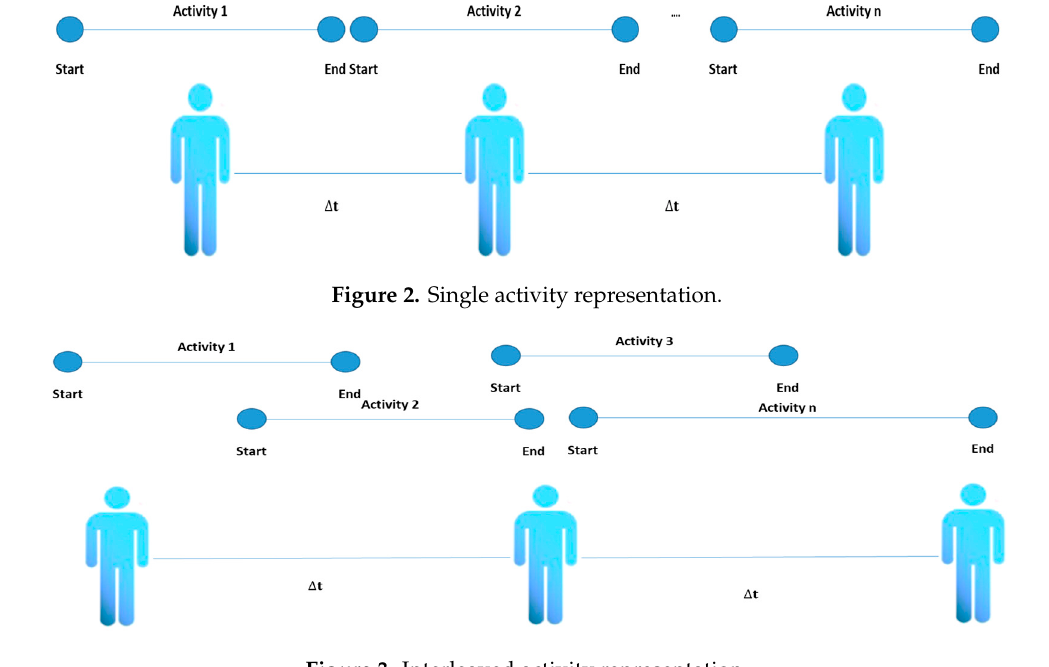
Figure 4. Multioccupancy activity representation.